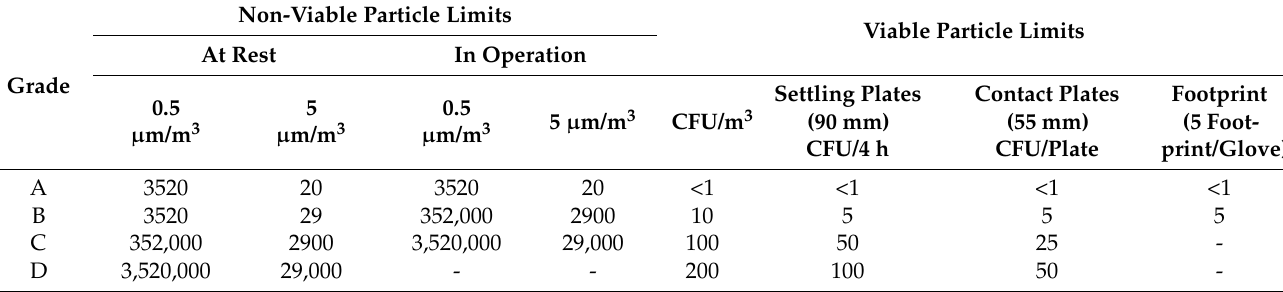
Table 3. Non-viable and viable particle counts. CFU: colony forming